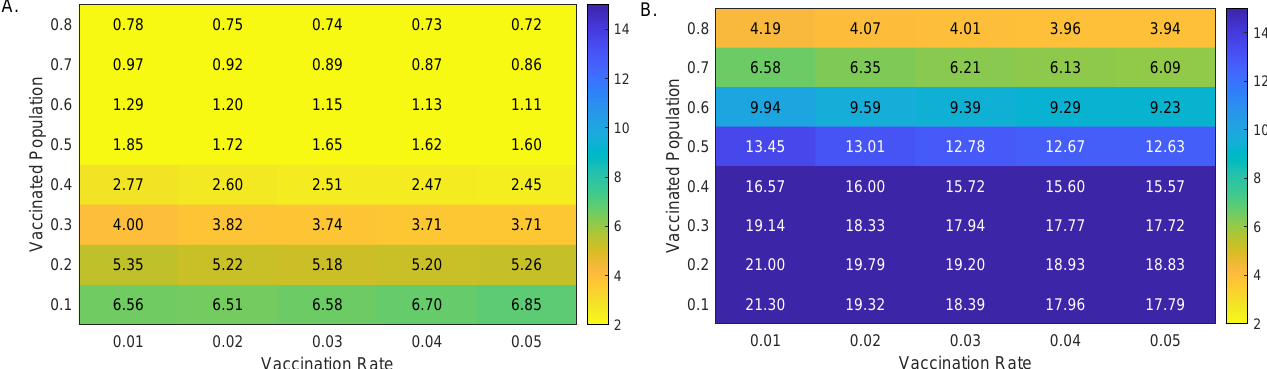
Figure 3. Percent breakthrough cases at day 100. Heatmaps for the percent breakthrough cases in the vaccinated population at day 100 versus additional daily vaccines, ν , and background vaccination levels, V 0 . Panel ( A ): Alpha variant; Panel ( B ): Delta variant. Parameters and initial conditions are given in Table 1.